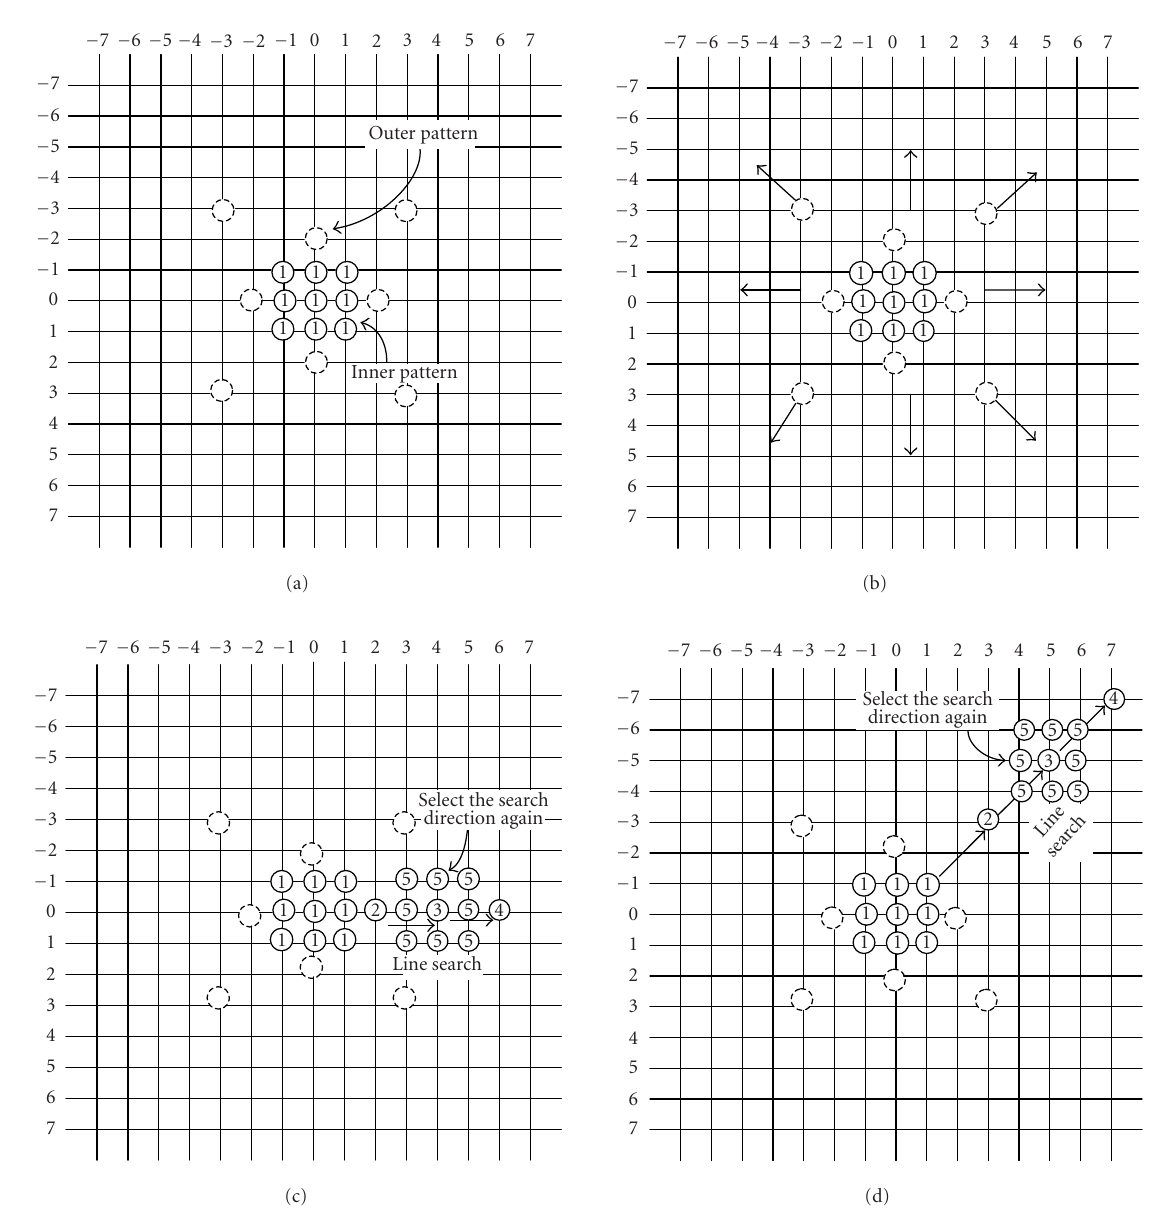
Figure 3: The pattern and search strategy of the LSPS algorithm: (a) square pattern (SP), (b) eight directions of the line search, (c) next step along the SP’s face, and (d) next step along the SP’s